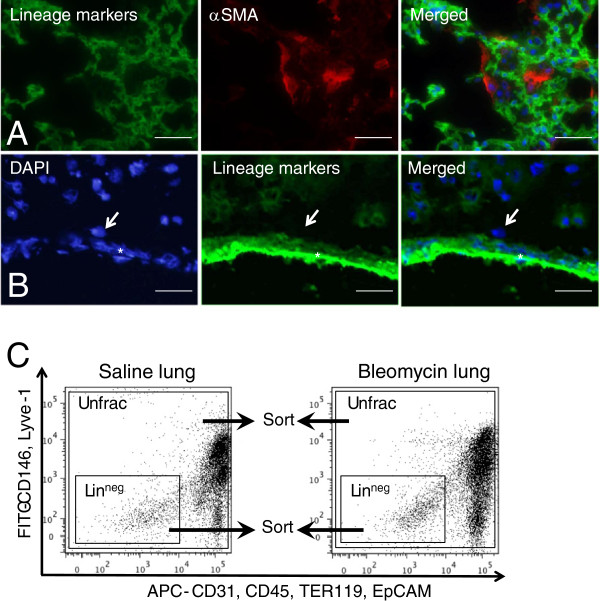
Lineage-specific cell surface markers were not expressed in myofibroblasts or perivascular cells. (A) Snap-frozen bleomycin-injured lungs at day 12 were fixed in acetone and examined by immunofluorescence using FITC-conjugated antibodies to lineage-specific cell surface markers (CD31, CD45, EpCAM, TER119, CD146, and Lyve-1) (left) and anti-α-SMA antibody (middle); these two images were merged with DAPI (blue in right). Figures show representative results. Scale bars indicate 100 μm. (B) Snap-frozen saline-treated lungs were fixed in acetone and examined by immunofluorescence with DAPI (left) and FITC-conjugated antibodies to lineage-specific cell surface markers (CD31, CD45, EpCAM, TER119, CD146, and Lyve-1) (middle); these two images were merged (right). Arrows indicate a cell that was localized in the adventitia of the pulmonary artery and that was negative for lineage-specific cell surface markers. The asterisk indicates the pulmonary artery. Figures show representative results. Scale bars indicate 50 μm. (C) Single lung cells, as shown in Additional file
1: Figure S3 were plotted for APC-conjugated anti-CD31, CD45, EpCAM, and TER119 antibodies vs. FITC-conjugated anti-CD146 and Lyve-1 antibodies. Unfractionated cells were sorted from the square in the figure. Linneg cells were sorted from the APC and FITC double-negative fraction, as shown in the oblong. Unfrac, unfractionated; DAPI, 4′,6-diamidino-2-phenylindole.